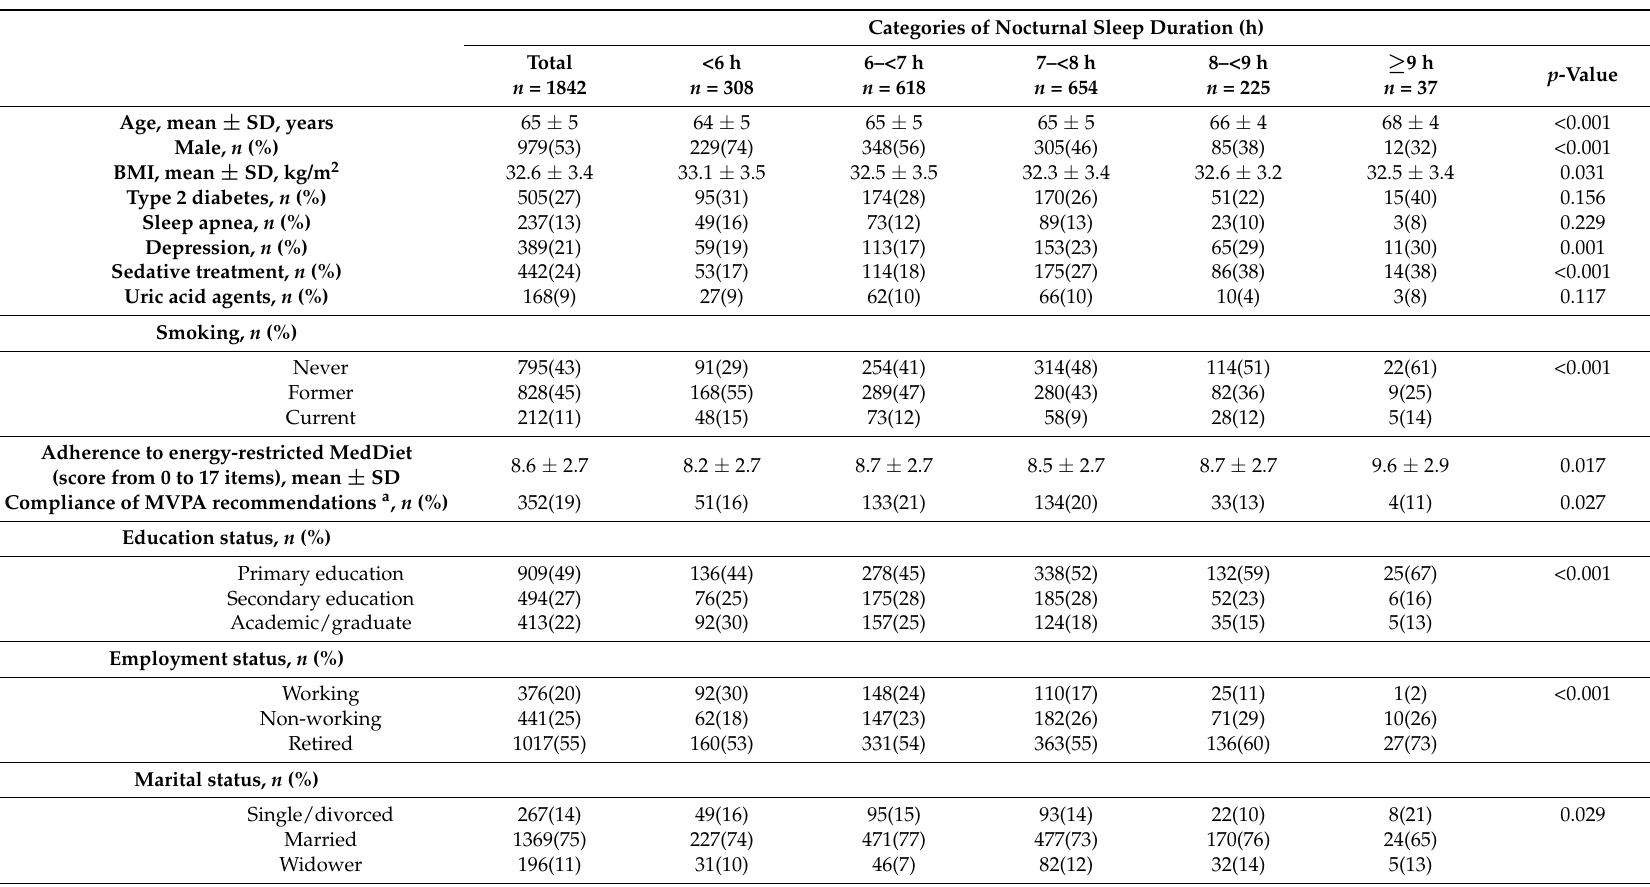
Table 1. General characteristics of the study population from Prevenci ó n con Dieta Mediterr á nea-Plus trial across categories of nocturnal sleep